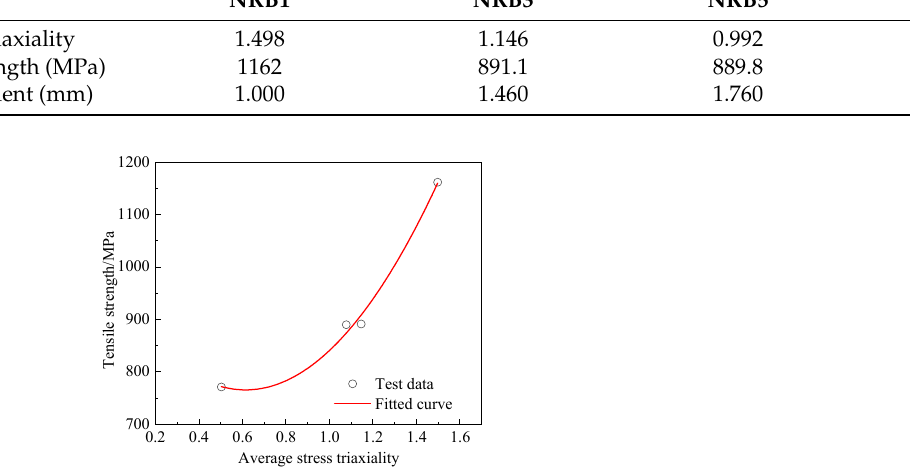
Test data Fitted curve